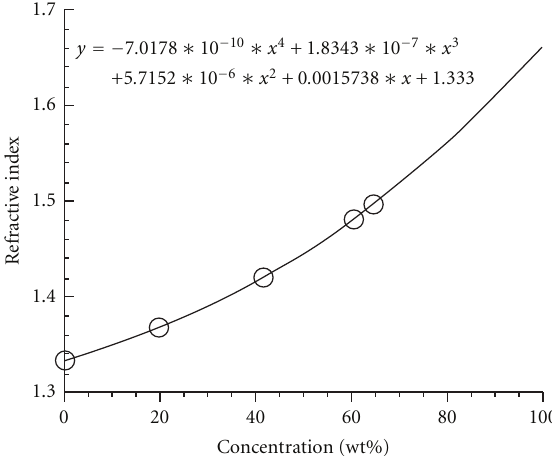
Figure 5: Correlation between refractive indices and concentra- tions of aqueous dispersions of SQ/ZrO 2 -NPs (feed molar ratio of APTMOS/ZTB =